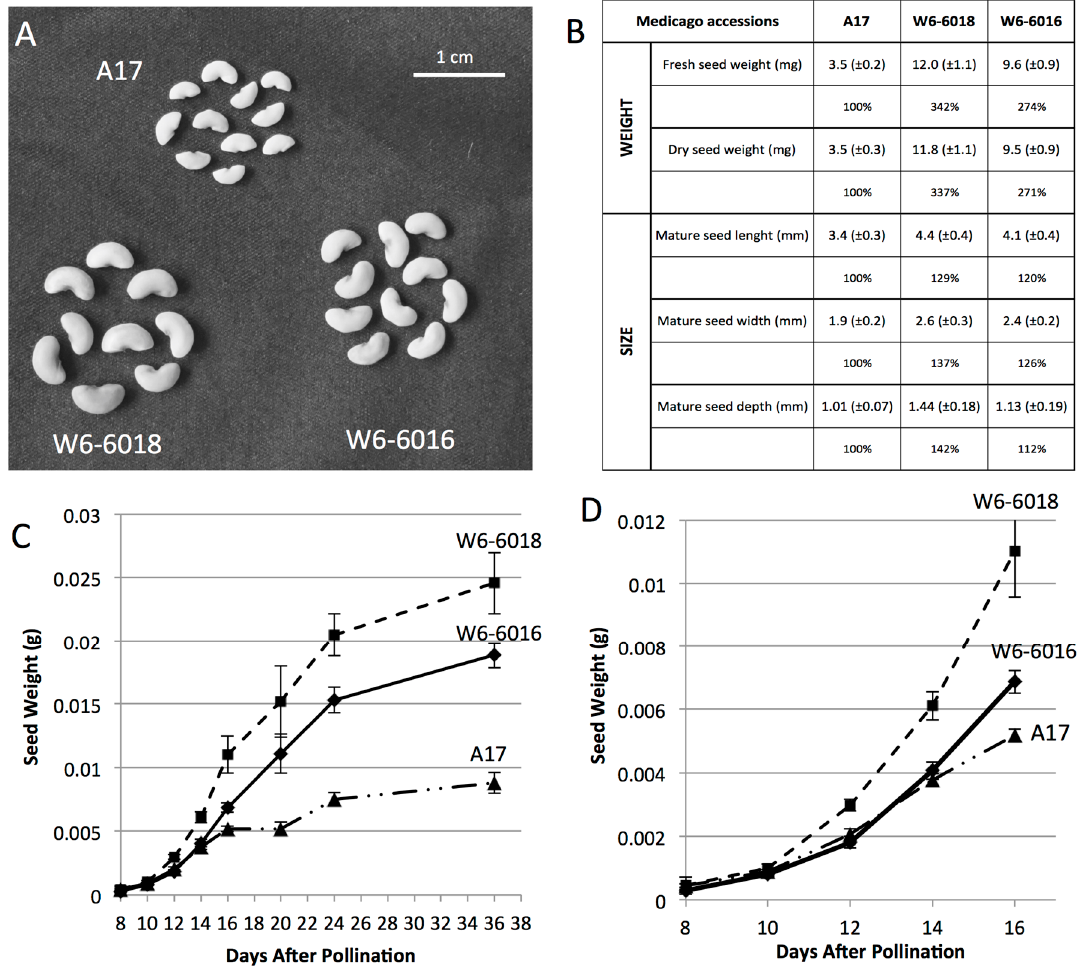
Figure 1. Seed growth patterns of different accessions of Medicago . ( A ) Pictures of mature seeds of the three accessions; ( B ) Mature seed weight and size of the different accessions from fresh and dry seeds. Values are averaged for one mature seed. Standard deviations are indicated between brackets. The percentage of weight/size increase with respect to the reference A17 is also indicated for each accession ( n > 50); ( C ) Average fresh weight of one seed of three Medicago accessions (A17, triangles; W6-6016, diamonds and W6-6018, squares) are plotted against their developmental stages (days after pollination) ( n = 100); ( D ) Magnification of figure 1C between 8 to 16 DAP.